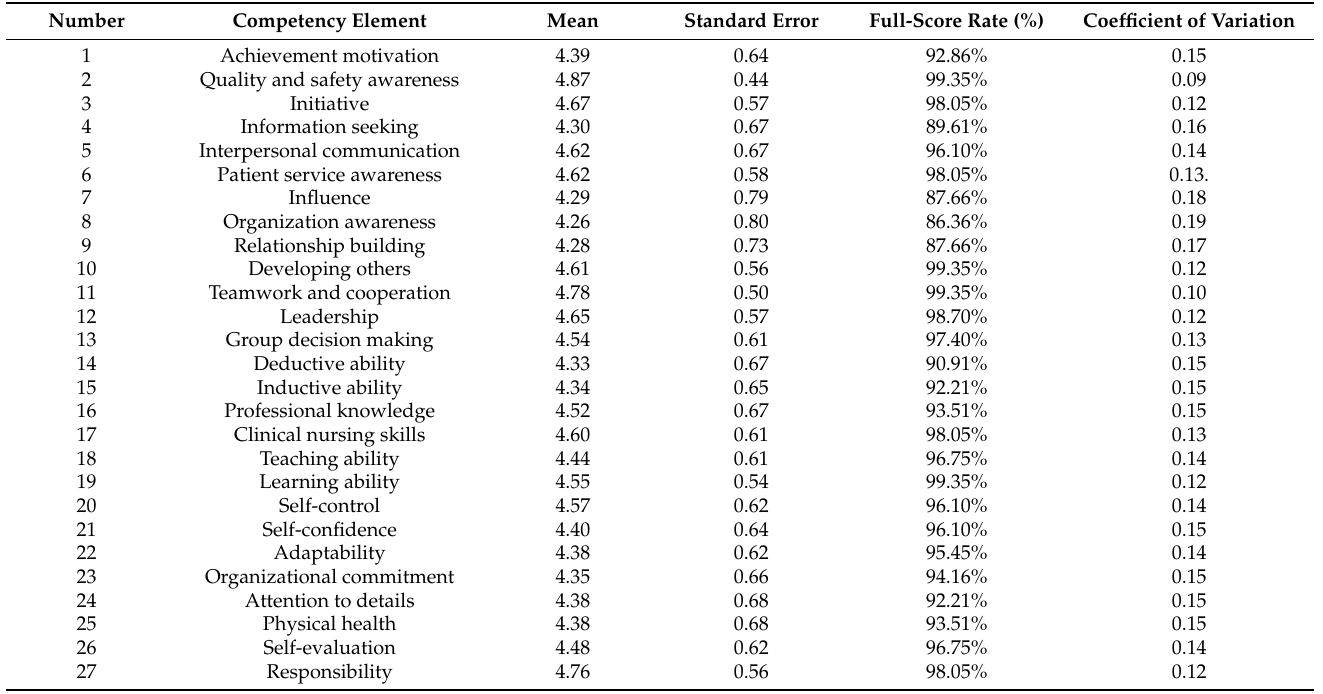
Table 2. Scores of importance of competency